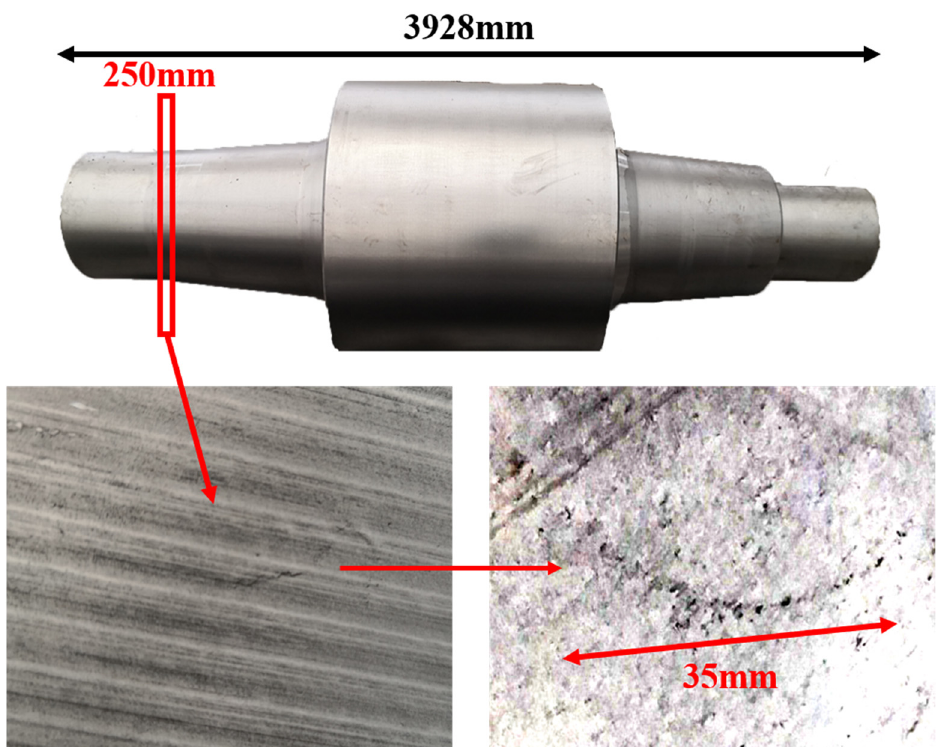
Figure 2. Sampling and defective part characteristics on the roller.